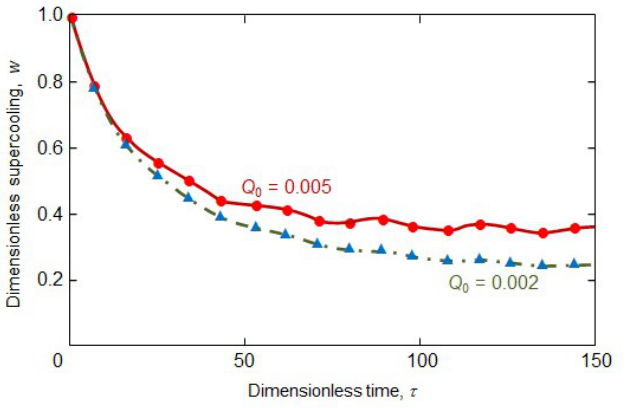
Figure 3. Metastability degree w = ∆ T / ∆ T 0 versus dimensionless time τ = t / t ∗ for the Meirs nucleation mechanism. The red solid and green dash-dotted curves are plotted accordingly to the analytical solutions (56). The red circles and blue triangles show the corresponding curves plotted accordingly to our solution (C3) (see the Appendix C). The system parameters used in calculations are: v 0 = 0.01, p = 2, t ∗ = 178 s, r 0 = 1.8 · 10 − 4 m, ζ ∗ = 5.6 · 10 − 6 , ζ p = 0.056, B 1 = 748, z 0 = 0.056,